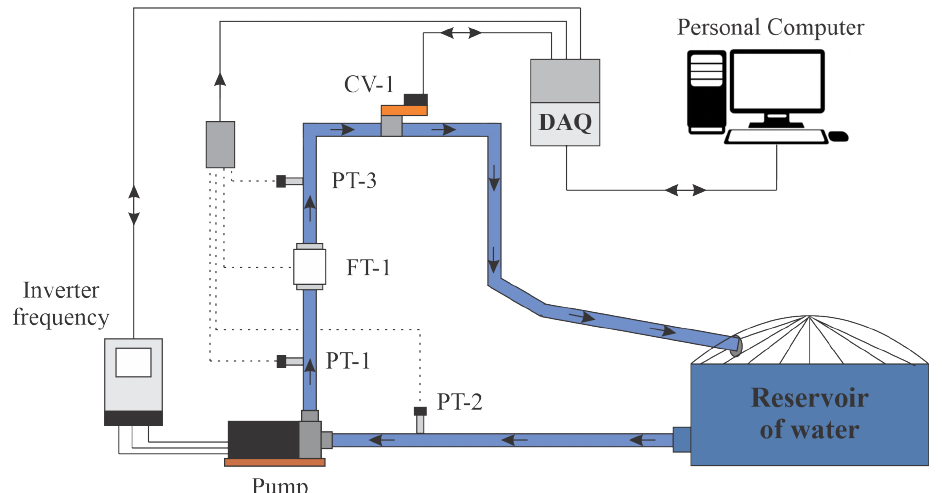
Figure 2. Schematic of the experimental